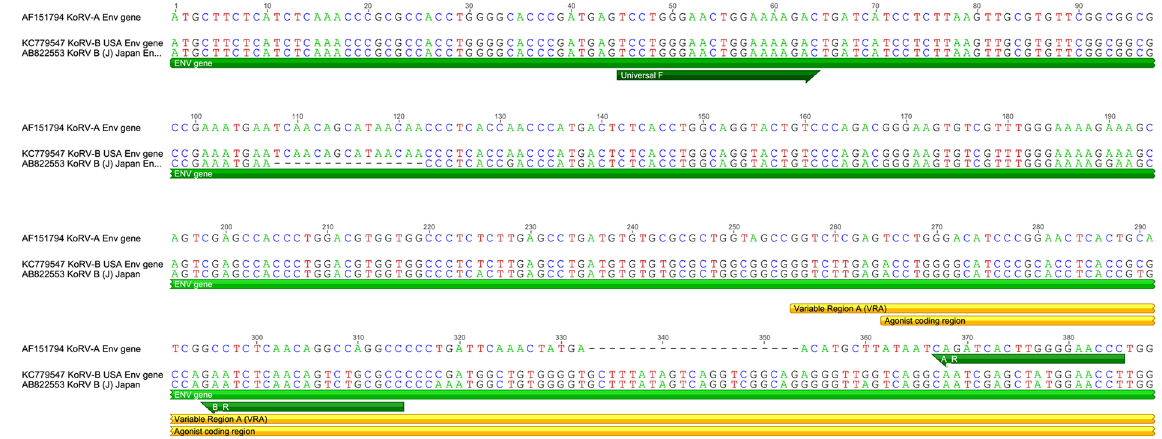
Figure 7. Location of PCR primers used to amplify koala retrovirus (KoRV) env region from the blood of free-living koalas ( Phascolarctos cinereus ). Primer coordinates are with respect to genome sequences which are representative of KoRV subgroup A (Genbank accession AF151794), subgroup B (Genbank accession KC779547), and subgroup J (Genbank accession B22553). Primer sequences are in Table S1. VRA: variable region A; LTR: long terminal